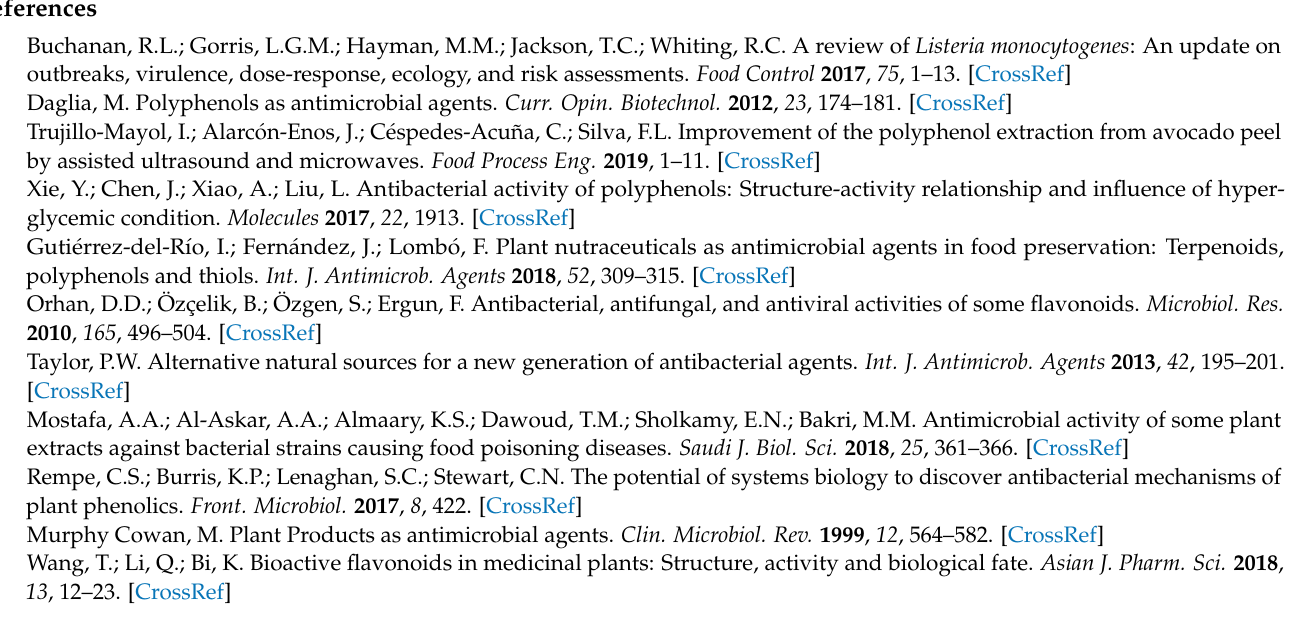
Figure A1. Experimental work chart. Abbreviations: high-performance liquid chromatography–quadrupole time-of-flight mass/mass spectrometry (HPLC-qTOF-MS/MS); Total Phenolic Content (TPC); Proanthocyanidin Content (PAC); 2,2-Diphenyl-1-picrylhydrazyl (DPPH) radical scavenging capacity; ferric reducing antioxidant power (FRAP); oxygen radical absorbance capacity (ORAC); Escherichia coli ( E. coli ); Salmonella spp.; Pseudomonas aeruginosa (P. aeruginosa); Listeria monocytogenes (L. monocytogenes) ; Staphylococcus aureus (S. aureus); Bacillus cereus (B. cereus).